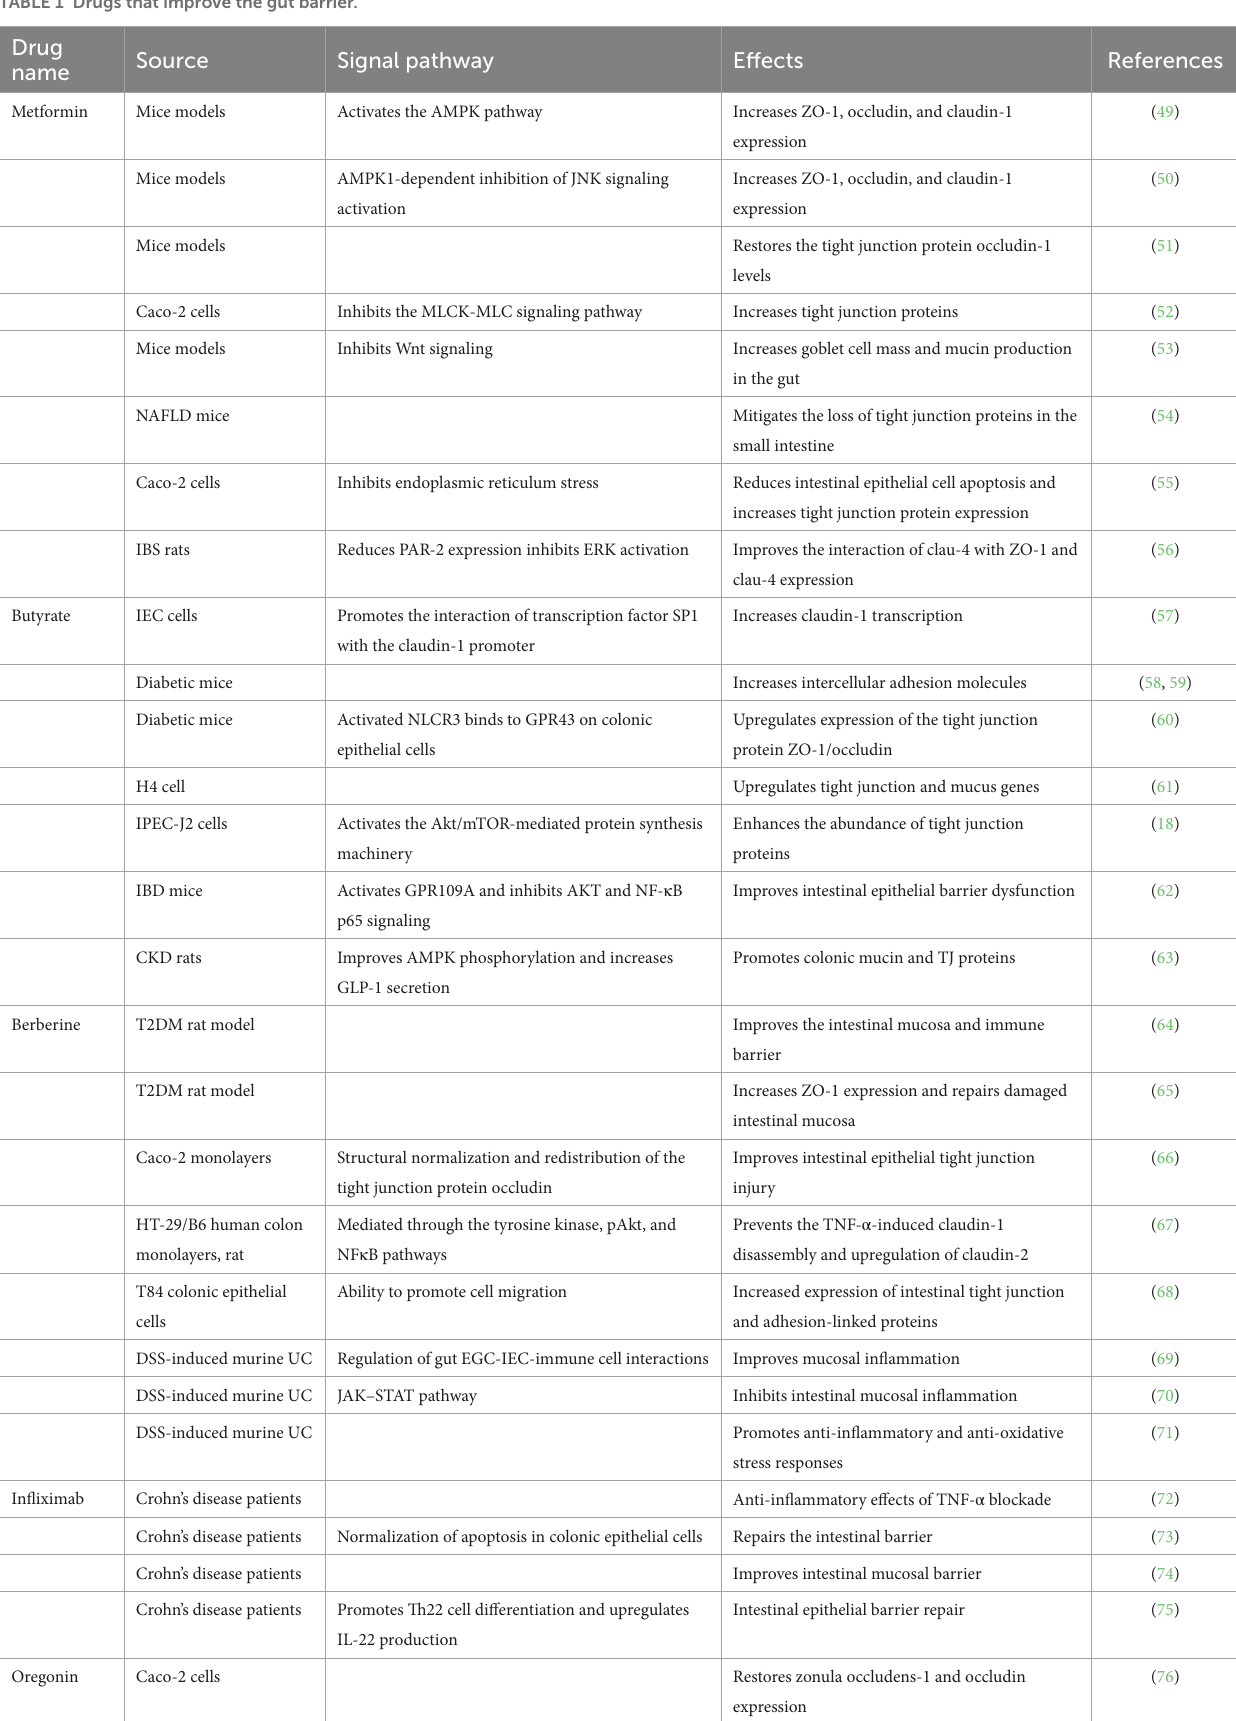
TABLE 1 Drugs that improve the gut